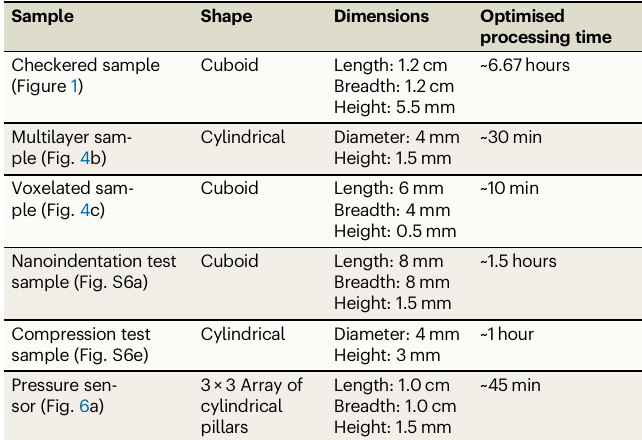
processing time